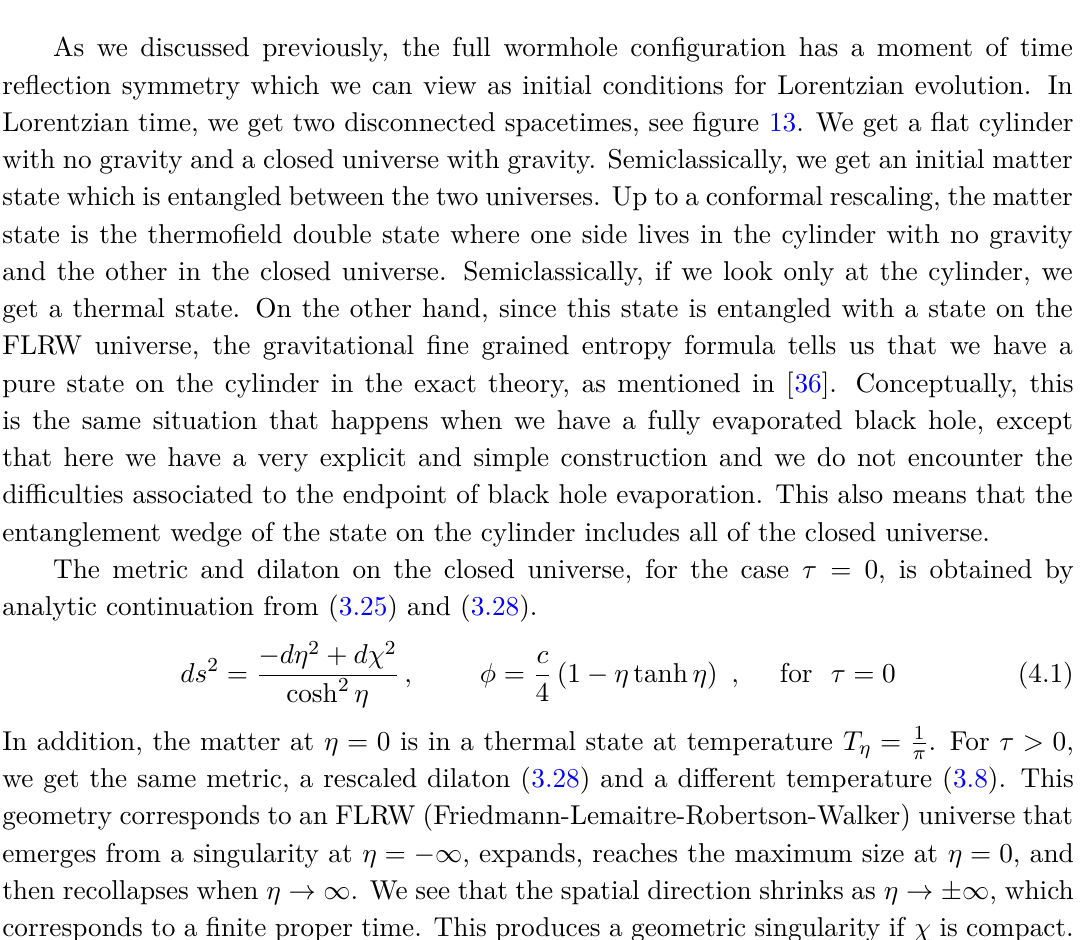
Figure 13 . Lorentzian continuation of the state prepared by the Euclidean evolution. On the right (yellow) we have a cylinder with no gravity. On the left (green) we have a initially expanding and then collapsing FLRW universe with dynamical gravity. The matter fields are in a thermofield double state, with each side on each of these two